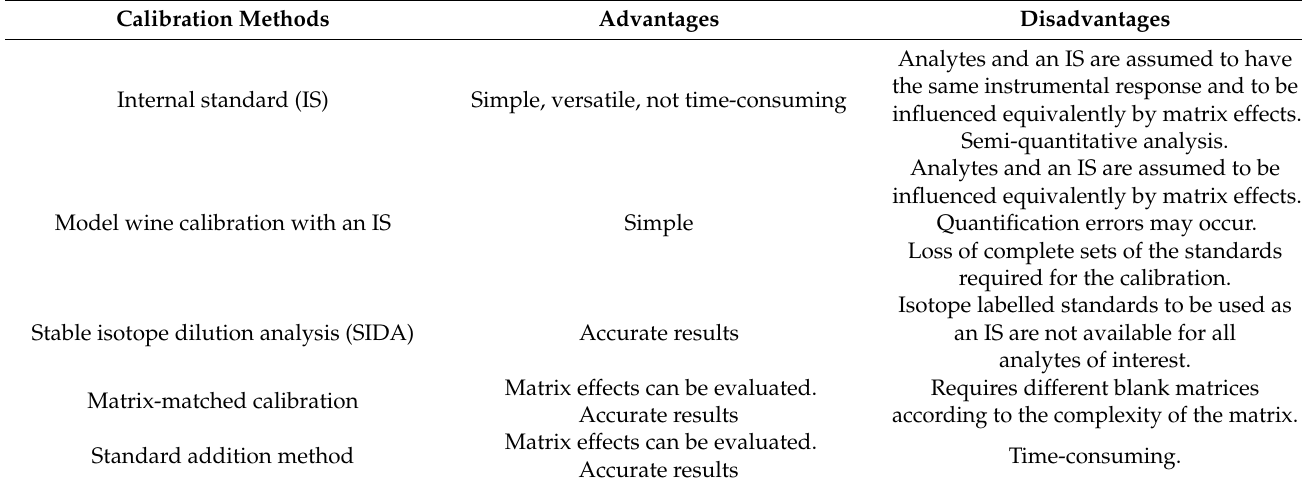
Table 1. Advantages and disadvantages of SPME calibration